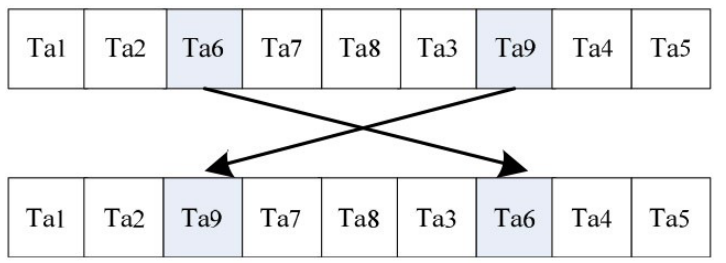
Figure 3. Random interchangeable